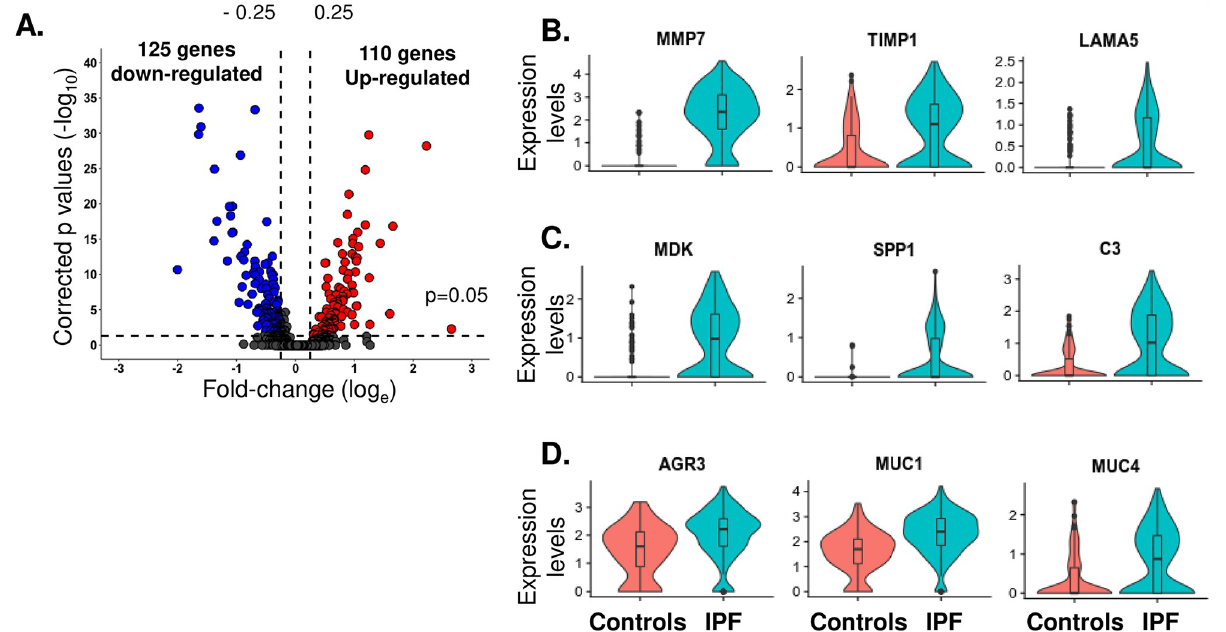
Fig 4. Transcriptomic dysregulation of SCGB3A2 high club cells in IPF. A. Volcano plots of significantly down-regulated (125 genes, blue ) and up- regulated (110 genes, red ) genes in SCGB1A1 + SCGB3A2 high club cells from IPF. Y-axis –p values (-log 10 ), x-axis –the fold-change (log e ). Cutoff: shown as dotted lines, fold-change (log e ) > 0.25 as the up-regulated genes or < -0.25 as the down-regulated genes, p value < 0.05 with Bonferroni correction. B. Violin plots of the expression of extracellular matrix-related genes (MMP7, TIMP1 and LAMA5) in SCGB1A1 + SCGB3A2 high club cells of controls vs IPF. C. Violin plots in the expression of growth factor-related genes (MDK, SPP1 and C3) in SCGB1A1 + SCGB3A2 high club cells from controls vs IPF. D. Violin plots of the expression of mucin-related genes (AGR3, MUC1 and MUC4) in SCGB1A1 + SCGB3A2 high club cells of controls vs IPF. In B. - D. , left– controls, right